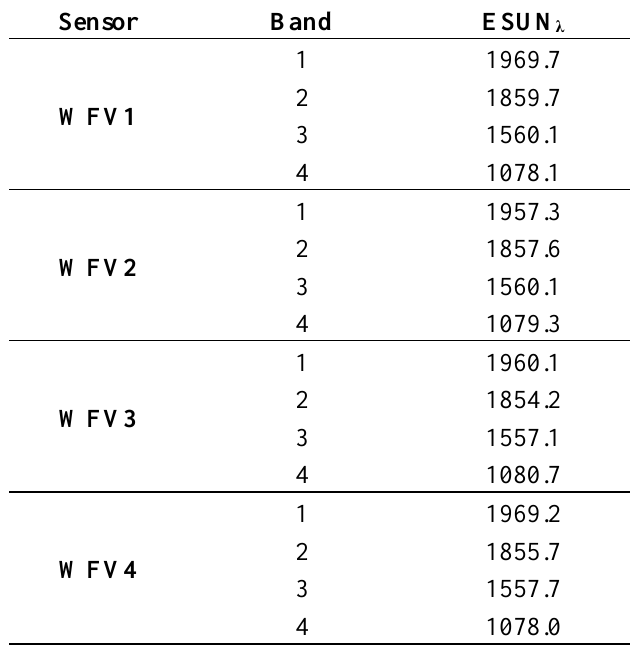
Table 13. Solar irradiance at the top of atmosphere of